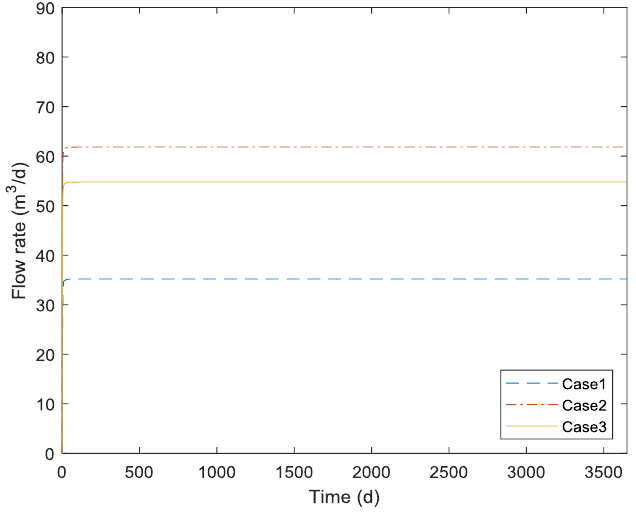
Figure 14. The production flow rate of the three cases.